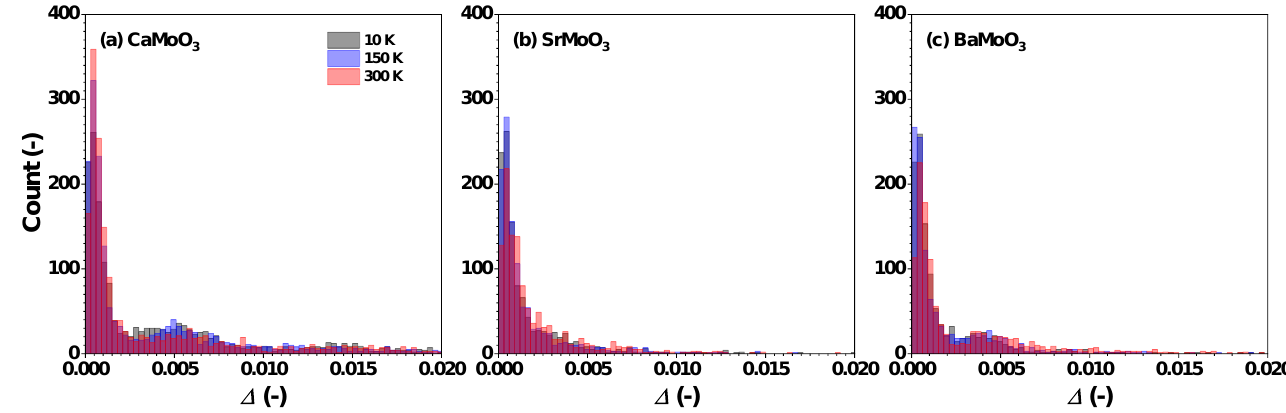
Figure 11. Histograms of calculated ∆ values (Equation (4)) describing the tilting distortion of [MoO 6 ] octahedra in polycrystalline ( a ) CaMoO 3 , ( b ) SrMoO 3 , and ( c ) BaMoO 3 at 10 K, 150 K, and 300 K. See text for